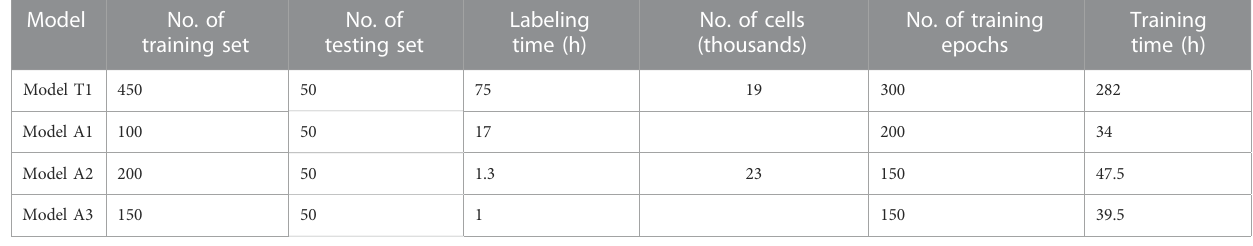
TABLE 1 Training and testing datasets.